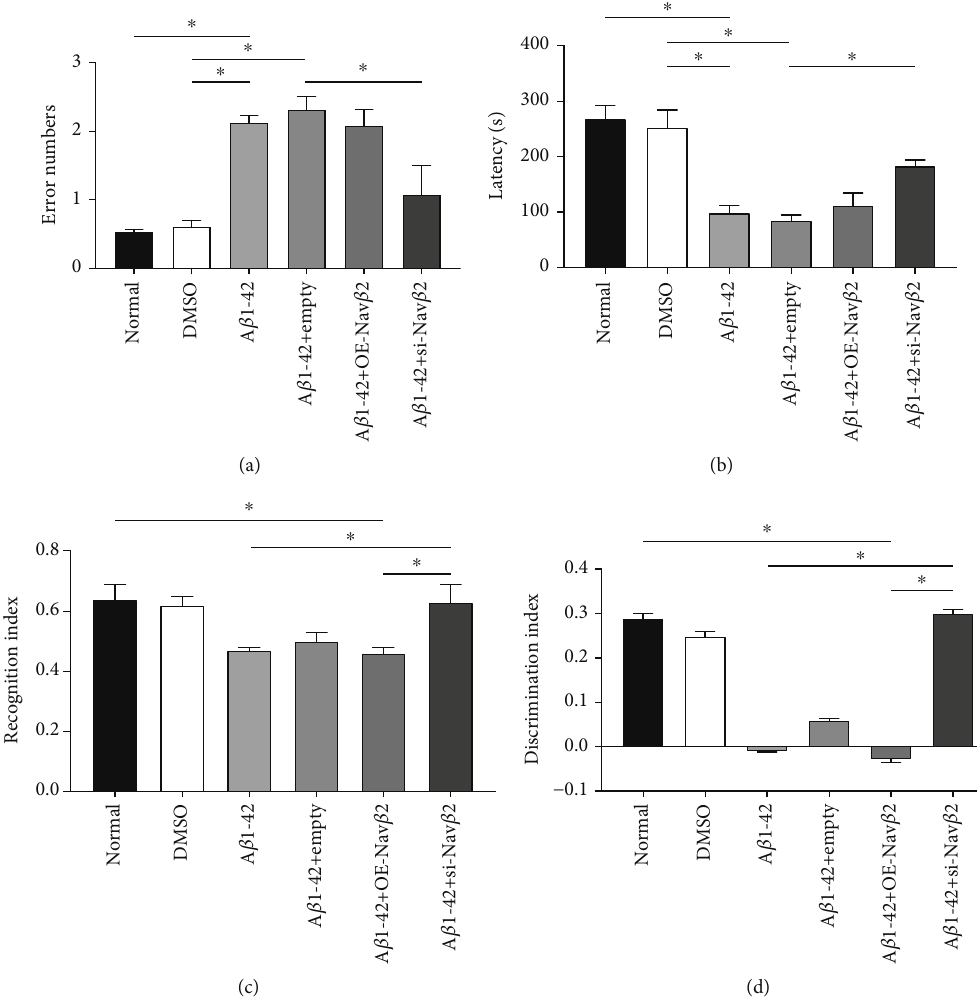
Figure 5: E ff ects of A β 1-42 and Nav β 2 on the cognitive and memory function in A β 1-42-treated mice. (a) Quantitative error times in passive avoidance experiment of mice after introduction of di ff erent lentivirus vectors ( n = 7 ). ∗ Versus two di ff erent treatment groups, P < 0 : 05 . (b) Quantitative incubation period in passive avoidance experiment of mice after introduction of di ff erent lentivirus vectors ( n = 7 ). ∗ Versus two di ff erent treatment groups, P < 0 : 05 . (c) Object recognition index (RI) in novel object recognition test of mice